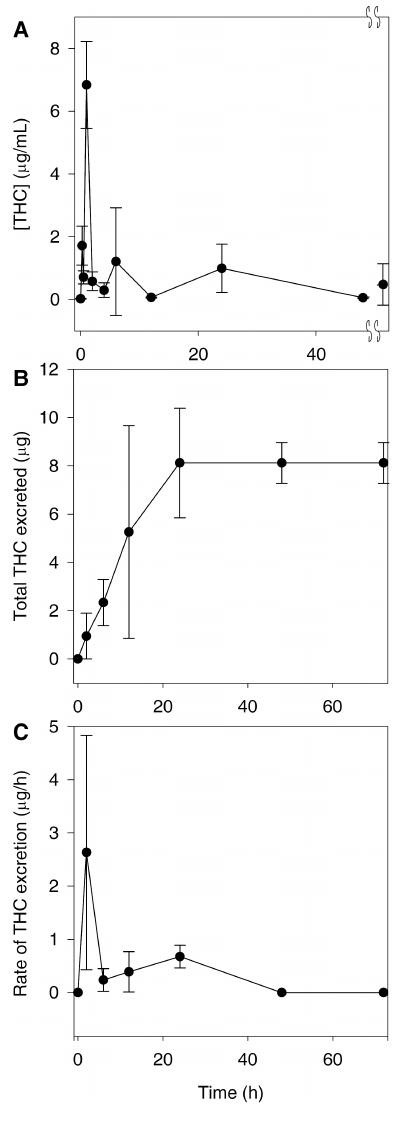
Figure 3. The pharmacokinetics of THC after a 500 mg/kg oral dose. Depicted is the serum disposition of THC in µg/mL ( A ) (the double S-marks represent a break in the Time axis from 49 to 71 h and the final time point is 72 h); the total amount of THC excreted in the urine in µg after oral administration ( B ); and the rate of urinary excretion of THC in µg/mL ( C ). All values represent a mean of 3 with standard deviation.